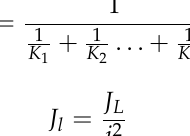
where K 1 , K 2 , · · · , K n are the stiffness of each part, or a series of parts, of the shaft. K is the equivalent joint stiffness. J L and J l are the actual load inertia and equivalent load inertia, respectively. i is the reduction ratio. The double inertia model of the system can be obtained, as shown in Figure 2.